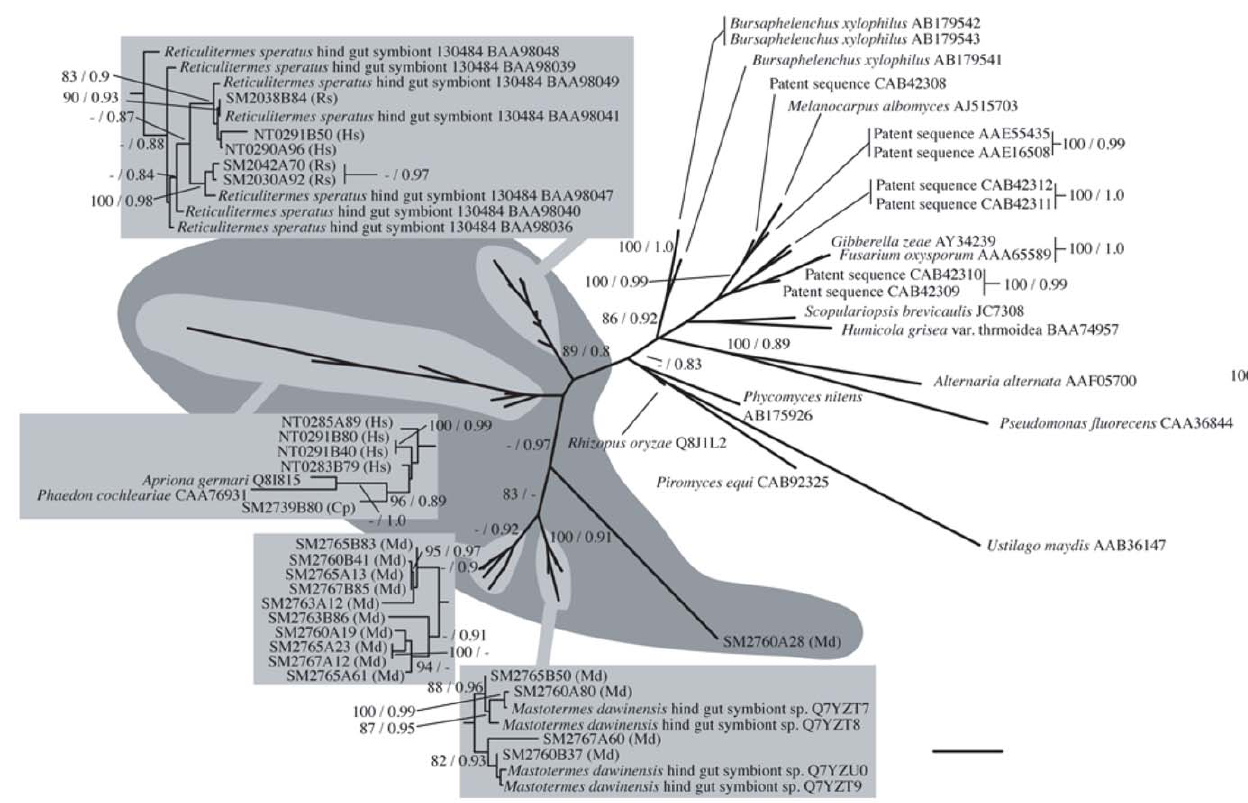
Figure 7. Phylogenetic tree of GHF45. Numbered clones (for example NT0285A89) are cellulase genes identified in this study from the symbiotic protists of termites. Letters in paretheses after each clone denote host termite species (Rs = Reticulitermes speratus , Nk = Neotermes koshunensis , Hs = Hodotermopsis sjostedti , Md = Mastotermes darwiniensis , Cp = Cryptocercus punctulatus ). Accession numbers of reference sequences are denoted after species names.